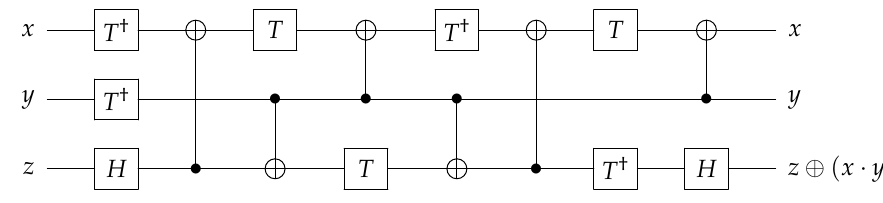
Figure 2. Decomposition of the Toffoli gate.